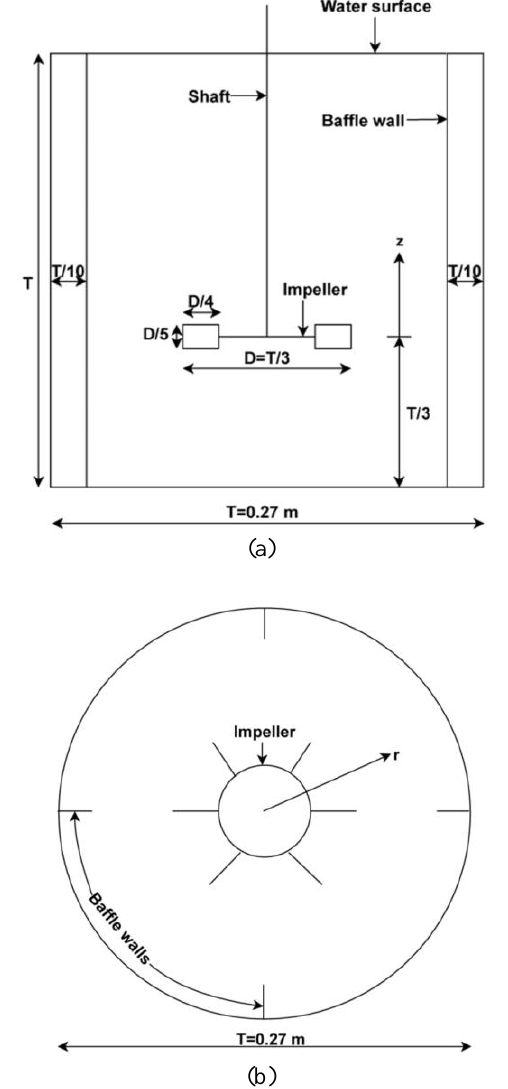
Figure 1. (a) Sectional elevation and (b) Plan of baffled stirred tank (Wu and Patterson,